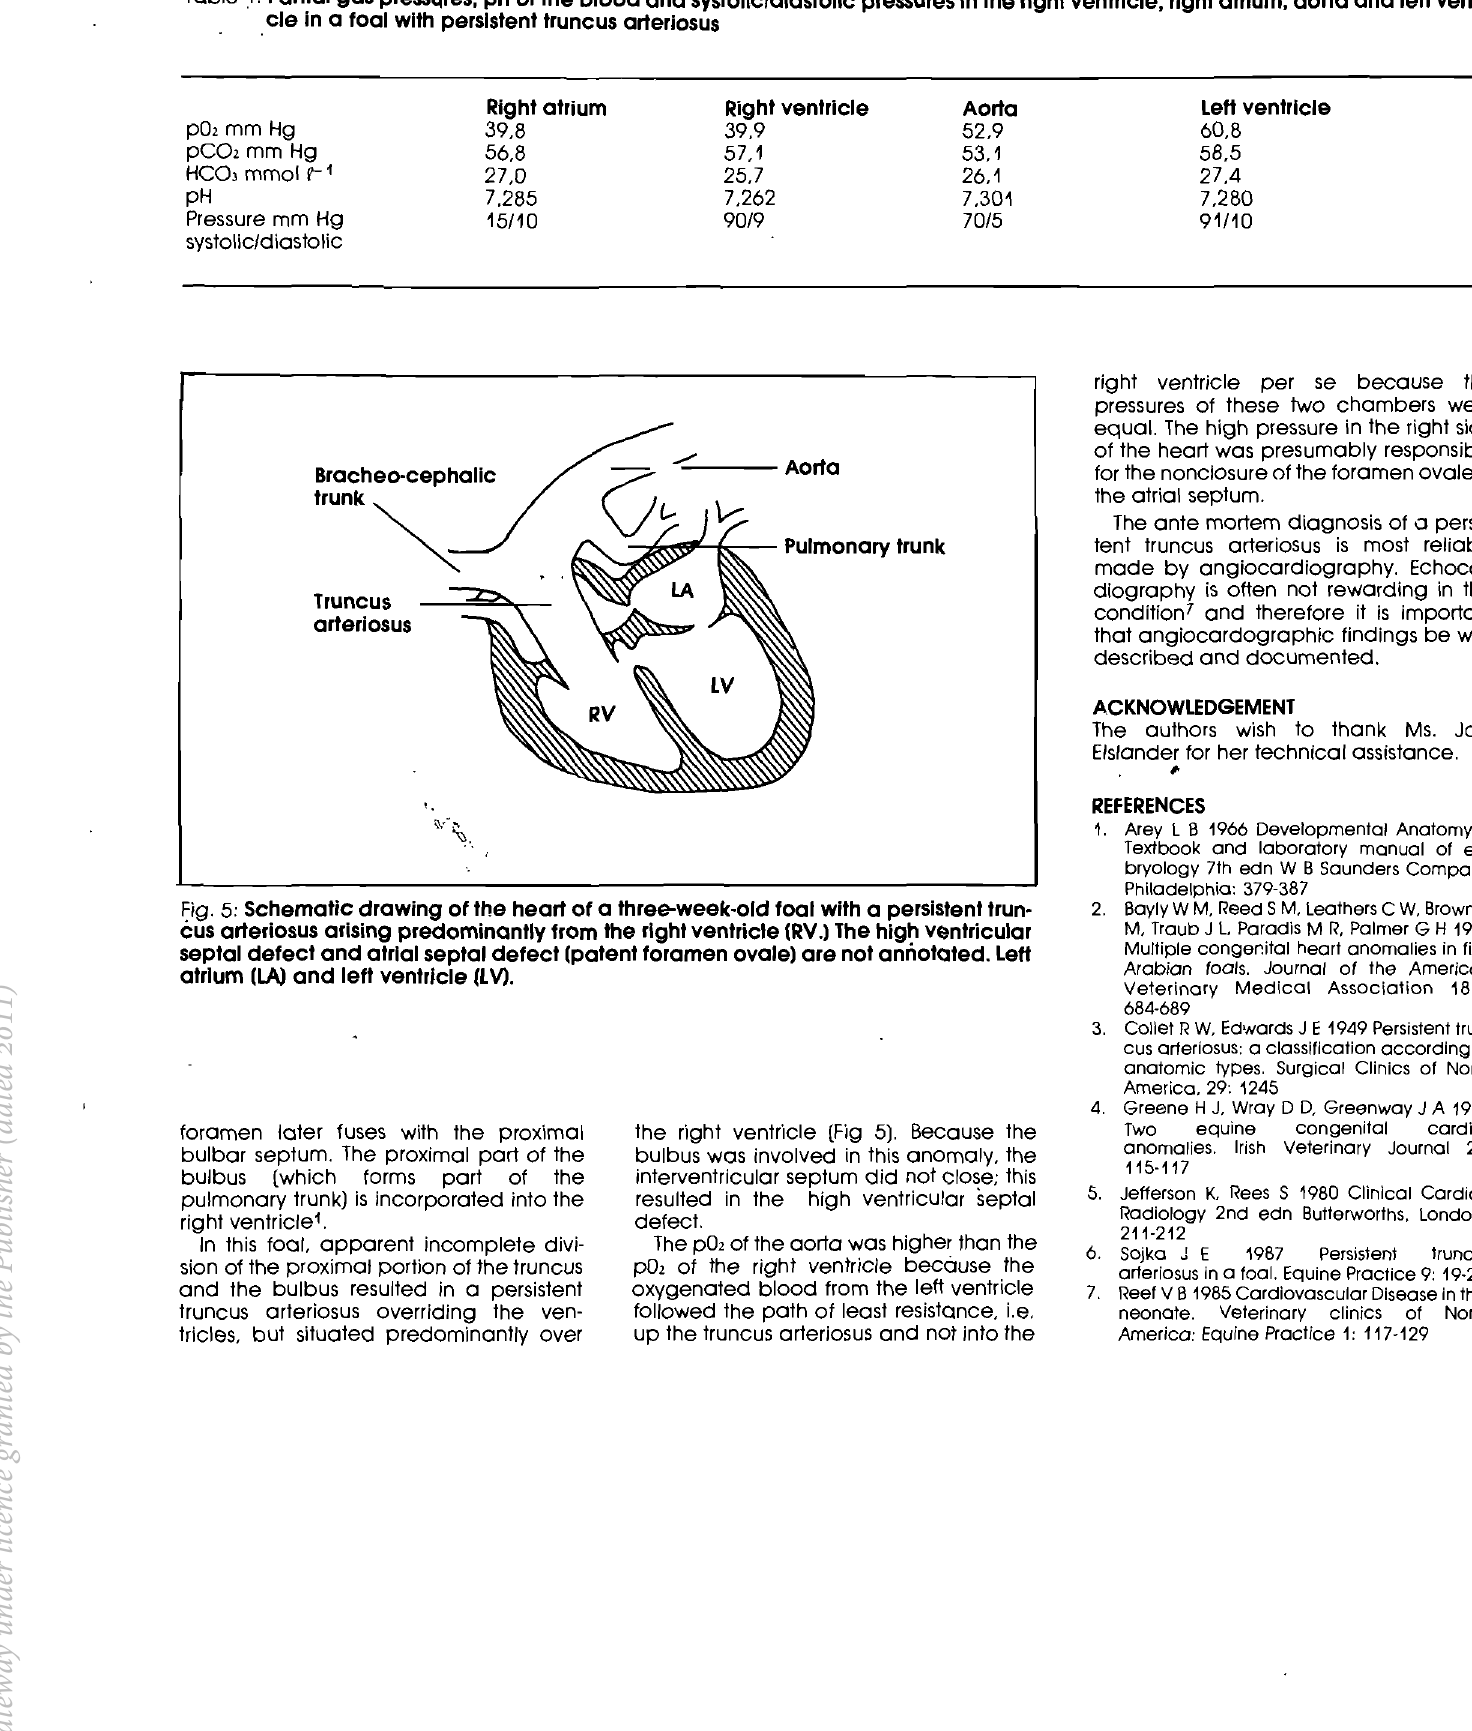
right ventricle per se because the pressures of these two chambers